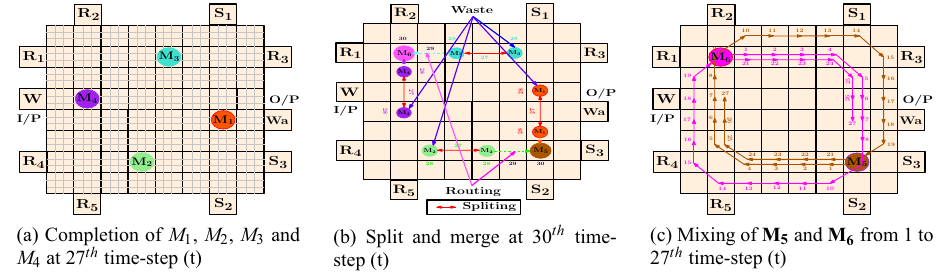
Fig. 15 a – b PCR layer 1 completion and corresponding split_merge steps. c Routing-based mixing paths for M 5 , M 6 for MEDA biochips